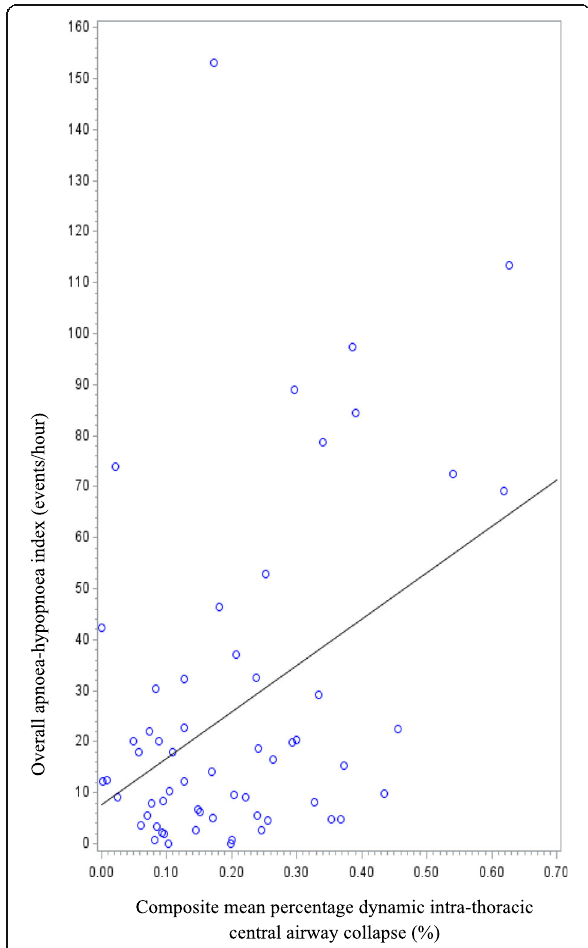
Fig. 1 Scatterplot demonstrating the association between dynamic intra-thoracic central airway collapse and overall apnoea-hypopnoea index. Legend: Composite mean percentage dynamic intra-thoracic central airway collapse is on the X axis and overall apnoea- hypopnoea index is on the Y axis, with the unadjusted linear model depicted by the solid black line (Pearson correlation coefficient 0.419 and with p =